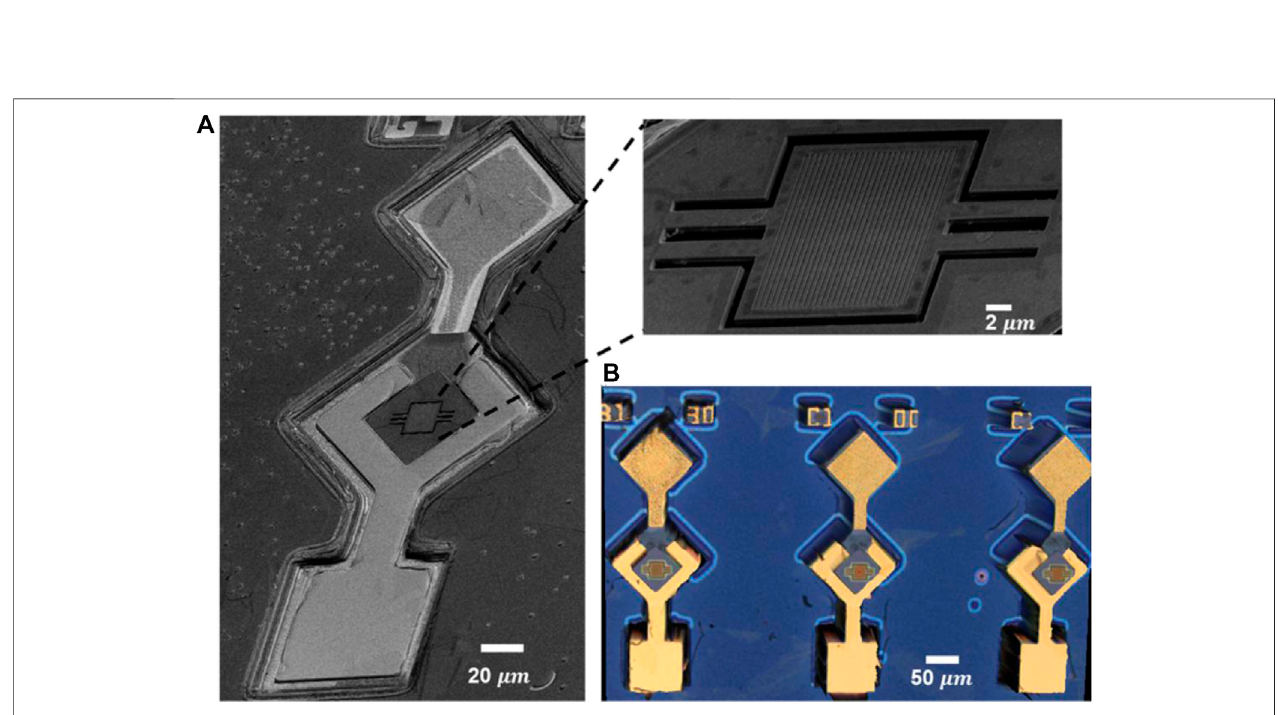
FIGURE2|(A) Scanningelectron microscope(SEM) imageofatypicalHCG-VCSELdevice,withazoomed-inviewofthefullysuspendedHCGsurroundedbyair. (B) 3D confocal optical image of the faburicated HCG-VCSEL array. Source : reproduced from Ref. 51.